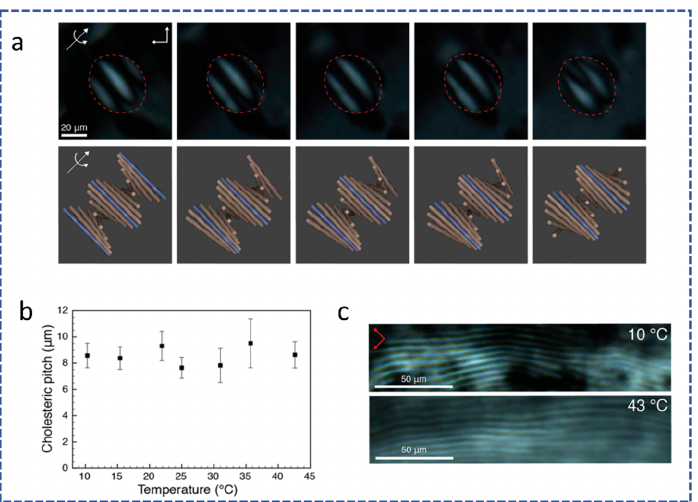
Figure 1. ( a ) Simple determination of handedness of chiral structure of CNCs through manual rotation under the microscope through rotation of a single isolated tactoid. ( b ) Insensitivity of pitch size to temperature over the time range of 10–40 degrees Celsius. ( c ) Visual variation of pitch size as a function of temperature (no discernible changes are found). Adapted with permission from Ref [56]. Copyright 2018 American Chemical Society.